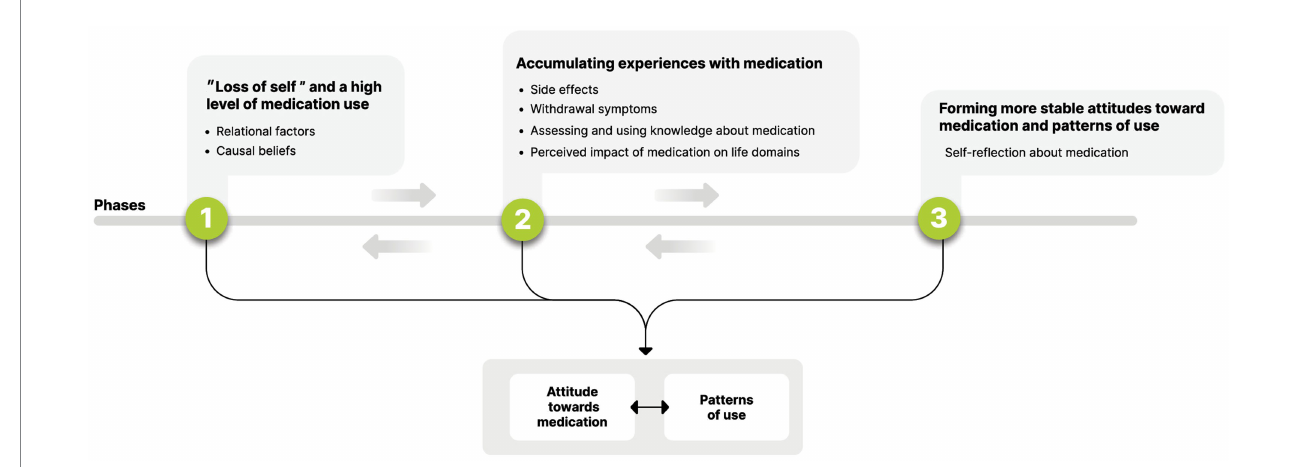
FIGURE 1 Longitudinal model of factors influencing attitudes toward medication and patterns of